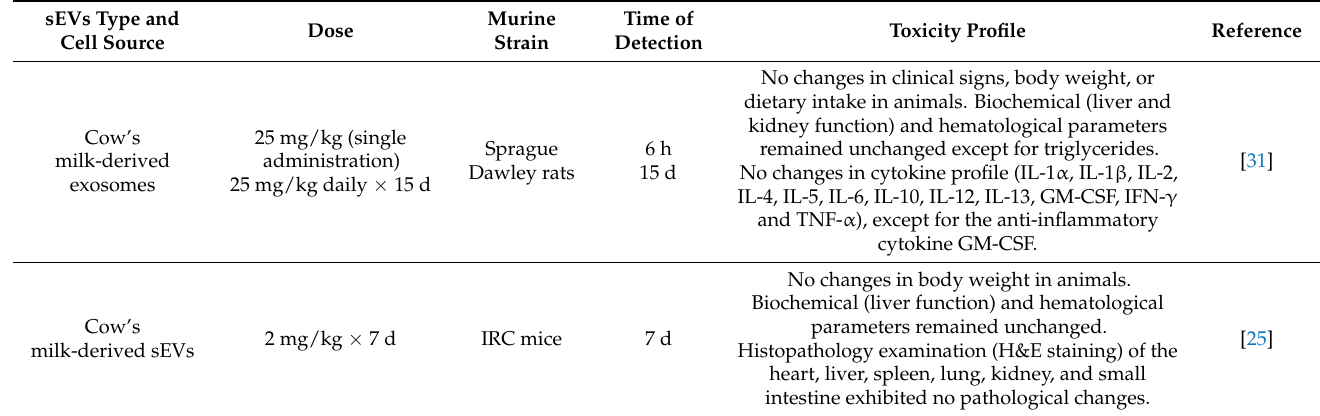
Table 2. Summary of the main findings related to toxicity studies after oral intake of sEVs.